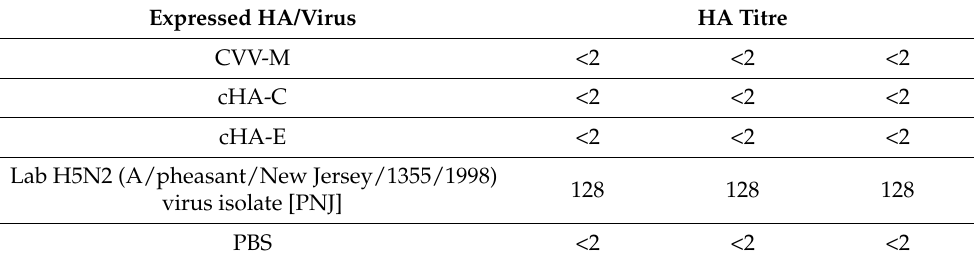
Table 3. Turkey red blood cell haemagglutination assessment of cHAs and candidate vaccine virus HAs.